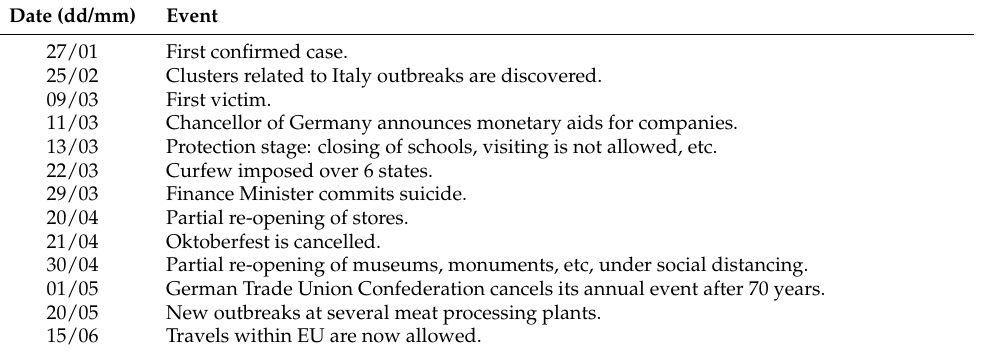
Table 5. Events and policies timeline related to the COVID-19 epidemic situation in Germany.